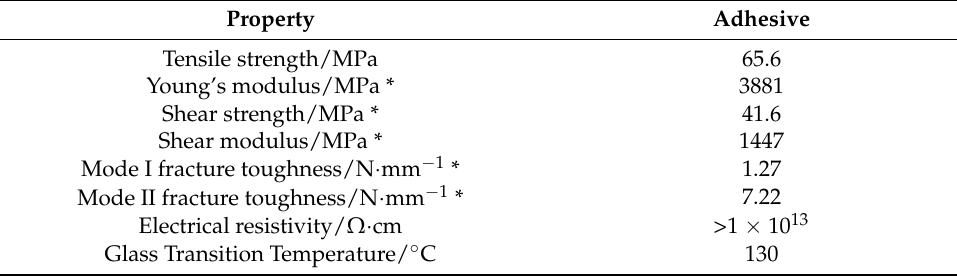
Table 1. Most relevant properties of the heat curing adhesive chosen for the